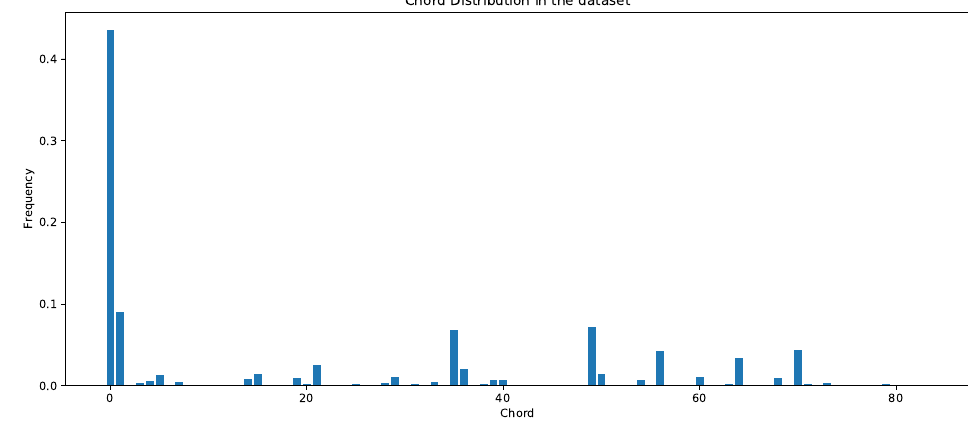
Figure 7. The chord distribution of our preprocessed HLSD. Each index corresponds to a chord symbol from {Cmaj, Cm, Cdim, C7, Cmaj7, Cmin7, Cdim7...Bmaj, Bm